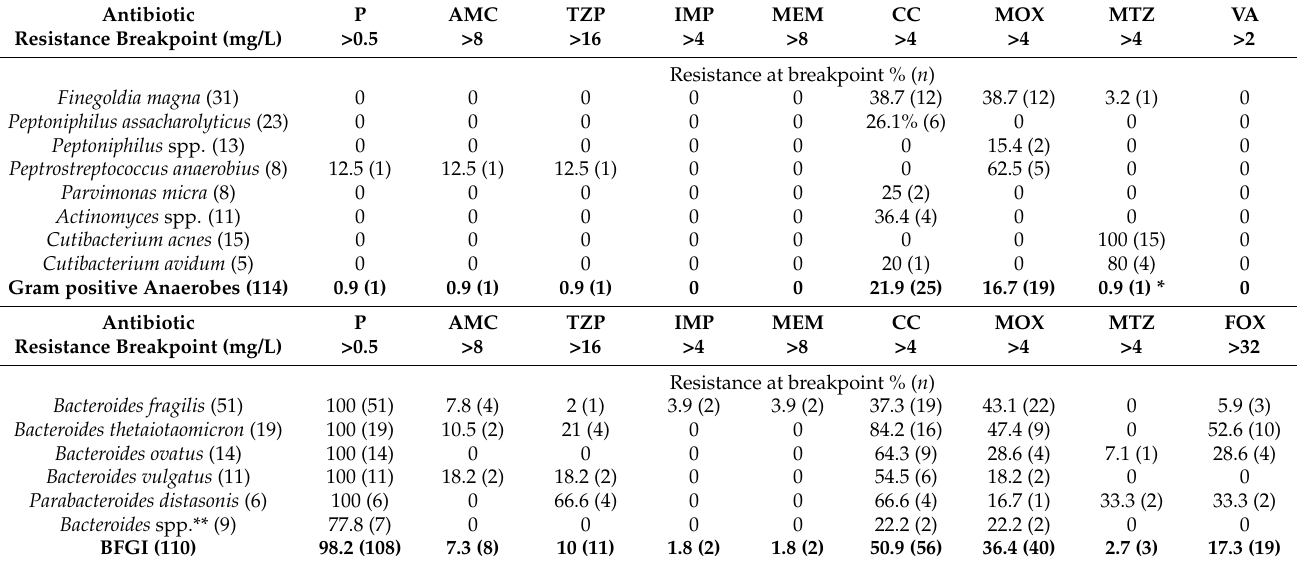
Table 1. Species distribution and in vitro resistance rates determined by MIC. Antibiotic P Resistance Breakpoint (mg/L)